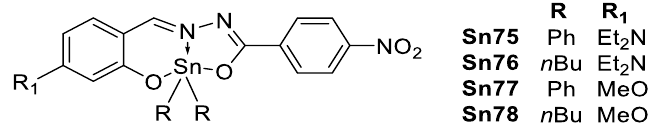
Figure 56. Diphenyl tin complexes reported by Muñoz-Flores et al. (Reprinted from [110], García-